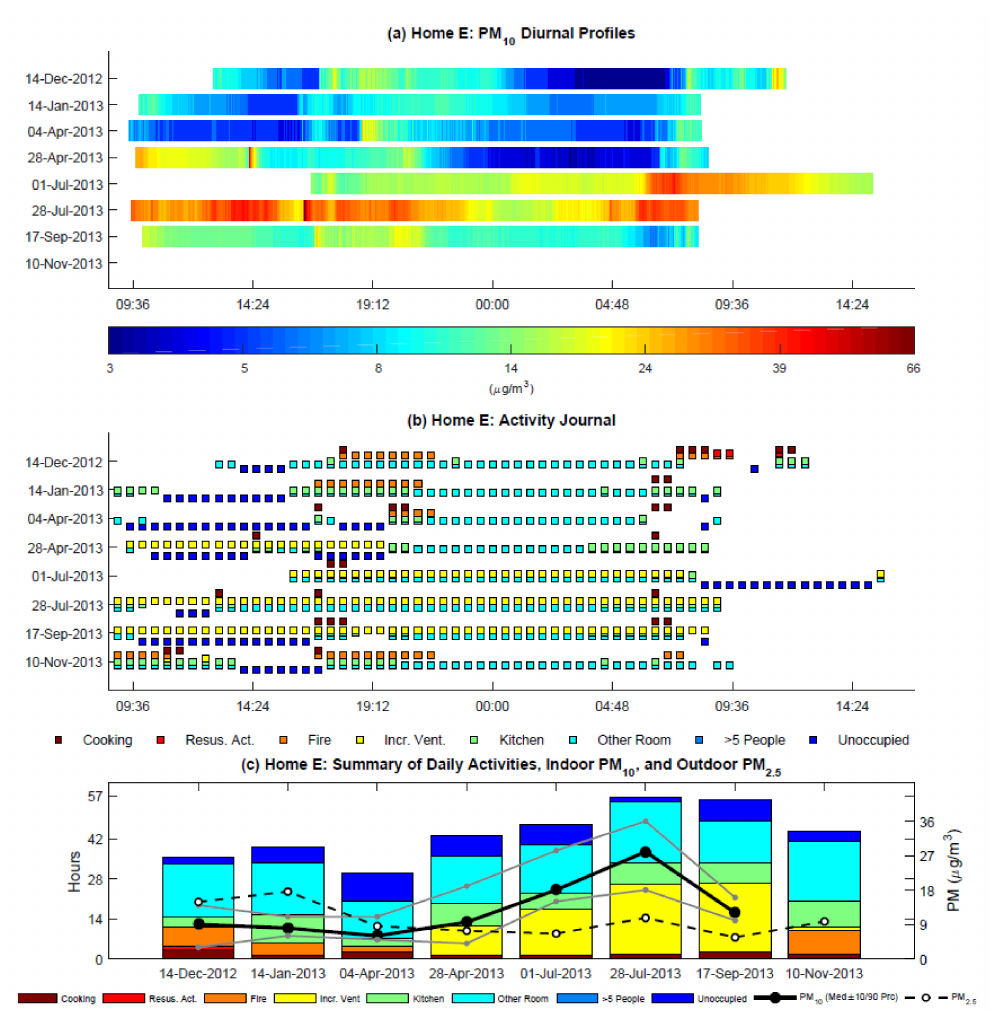
Figure 6. ( a ) Indoor PM10 diurnal profiles; ( b ) activity journal on half-hour intervals; and ( c ) summed activity-hours per day, indoor PM 10 , and outdoor PM 2.5 concentrations for Home